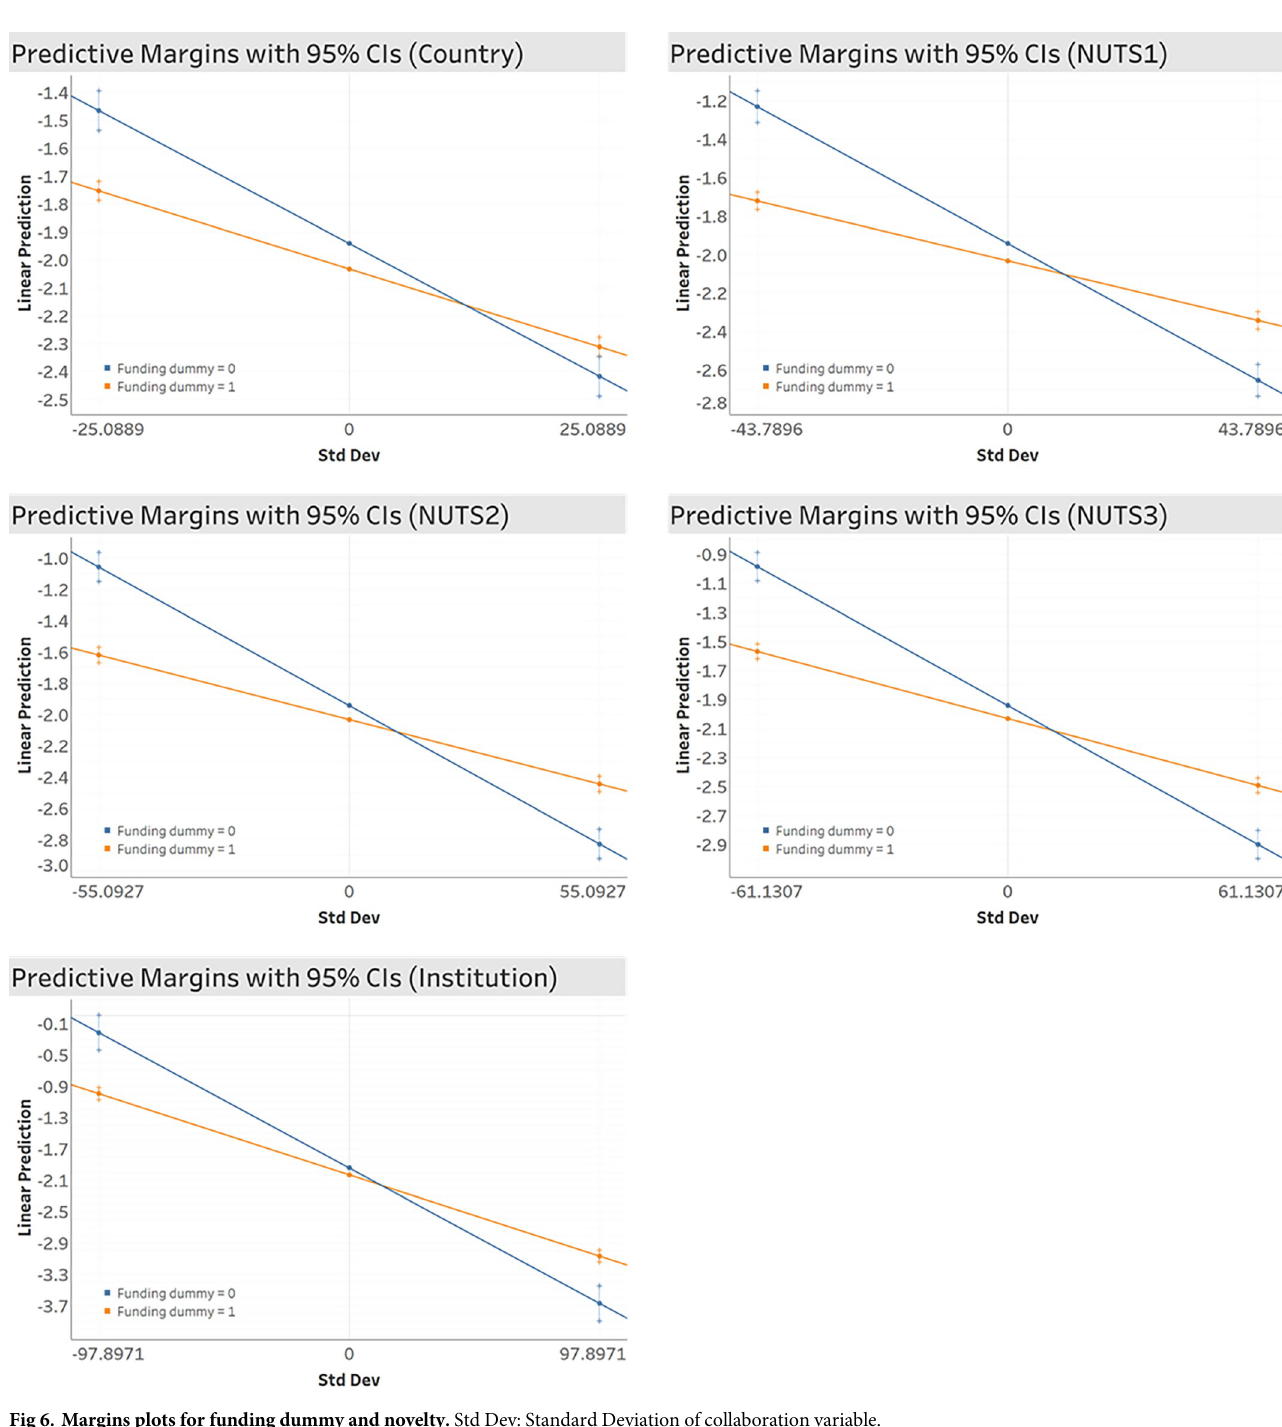
that papers funded by multiple agencies have the lowest novelty. Nevertheless, both interaction variables are positive and significant throughout all levels of collaboration except for Col � Sin- gle at institutional level. Also, Col � Multiple coefficients are higher than Col � Single , showing that moderating effect is ranked in multiple, single, and no agency order.